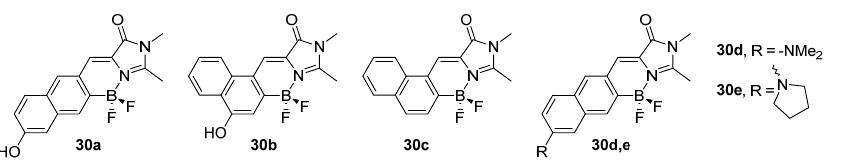
Figure 28. GFPc analogues with a more conjugated backbone [46].